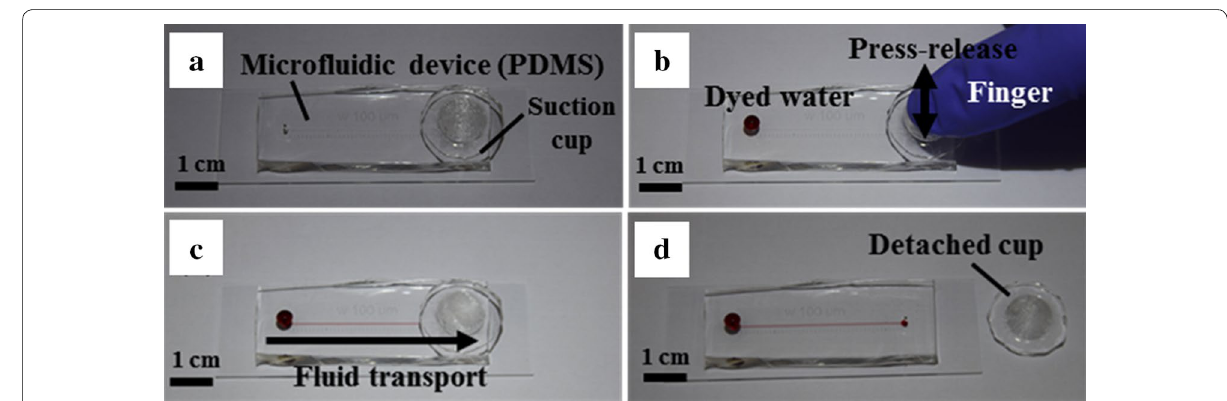
Fig. 3 Suction cup-driven equipment-free fluid pumping. a – d Finger-triggered pumping and reversible integration of the PDMS suction cup to the microfluidic